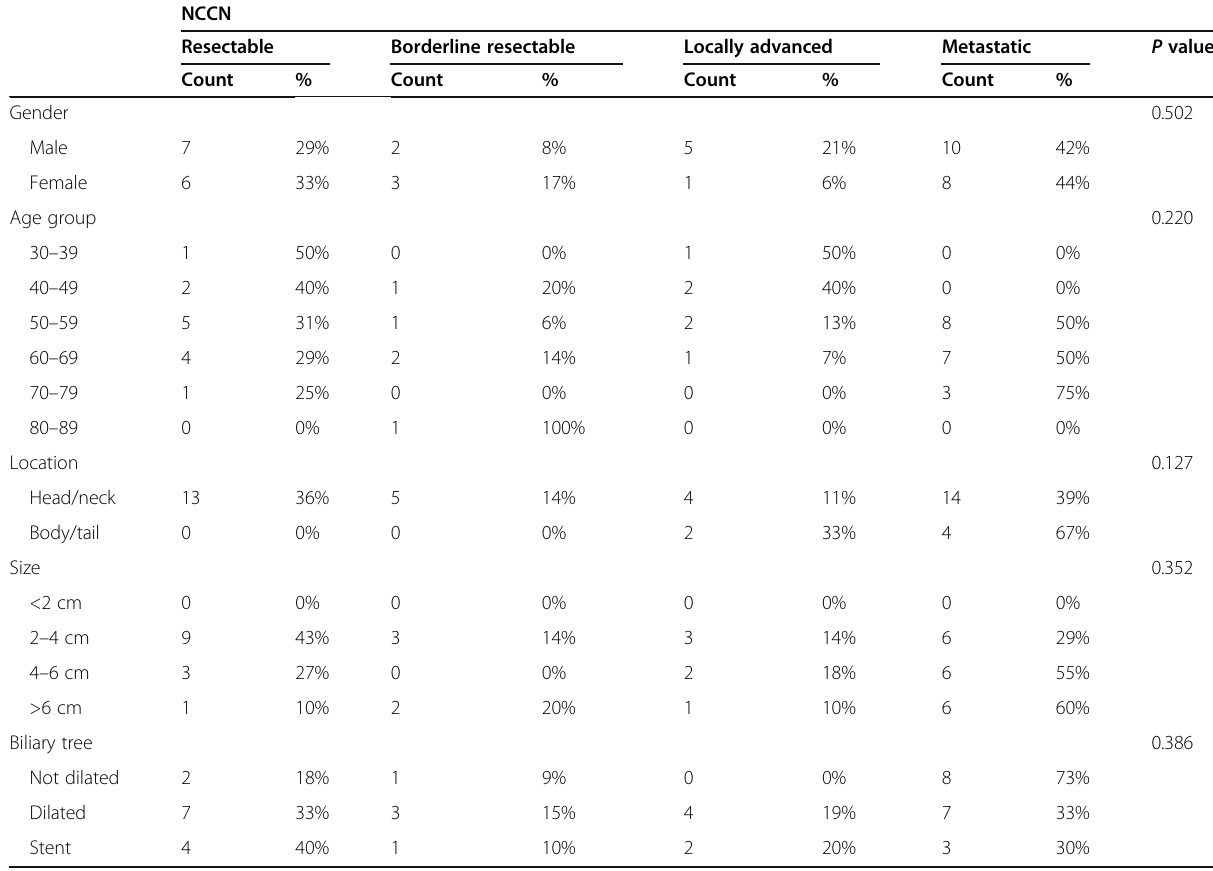
Table 5 Gender, age group, location, size, and effect on biliary tree in comparison to MDCT resectability